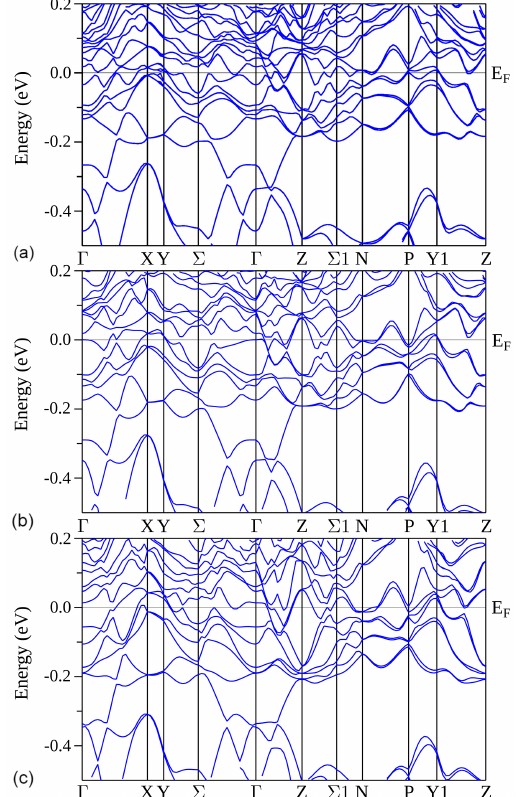
Figure 8. The band structure calculated along high symmetry k lines in the Brillouin zone of Sc 5 Rh 6 Sn 18 ( a ), Y 5 Rh 6 Sn 18 ( b ), and Lu 5 Rh 6 Sn 18 ( c ). The calculations were performed for U d = 3 eV (for Lu 5 Rh 6 Sn 18 , U d = 3 eV) and U f = 6.8